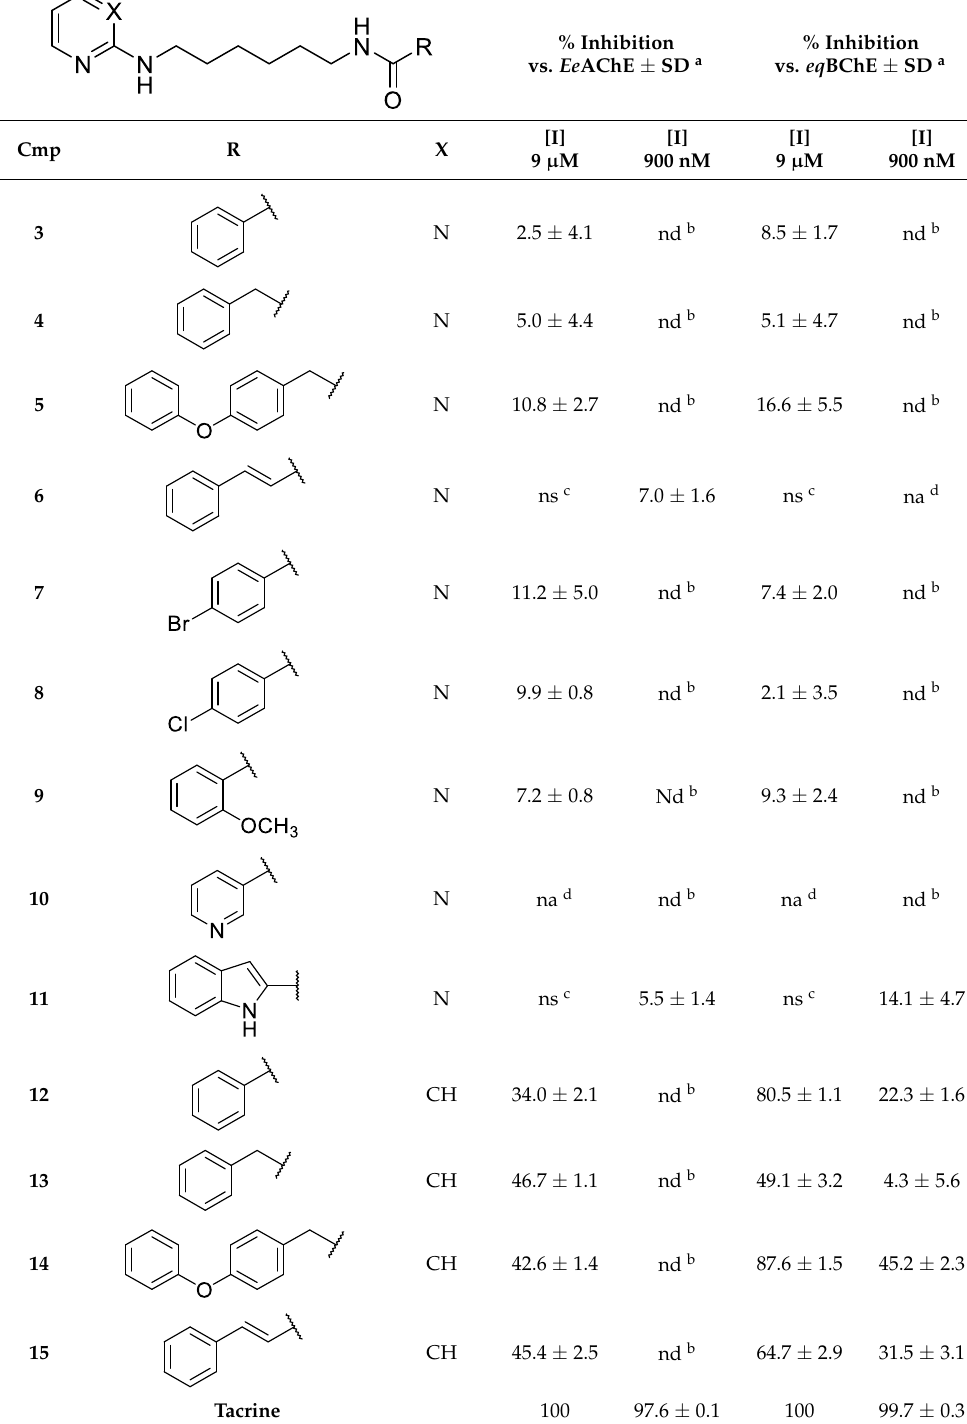
Table 1. Inhibition of Ee AChE and eq BChE activities by pyrimidine and pyridine amide derivatives 3 – 15 .